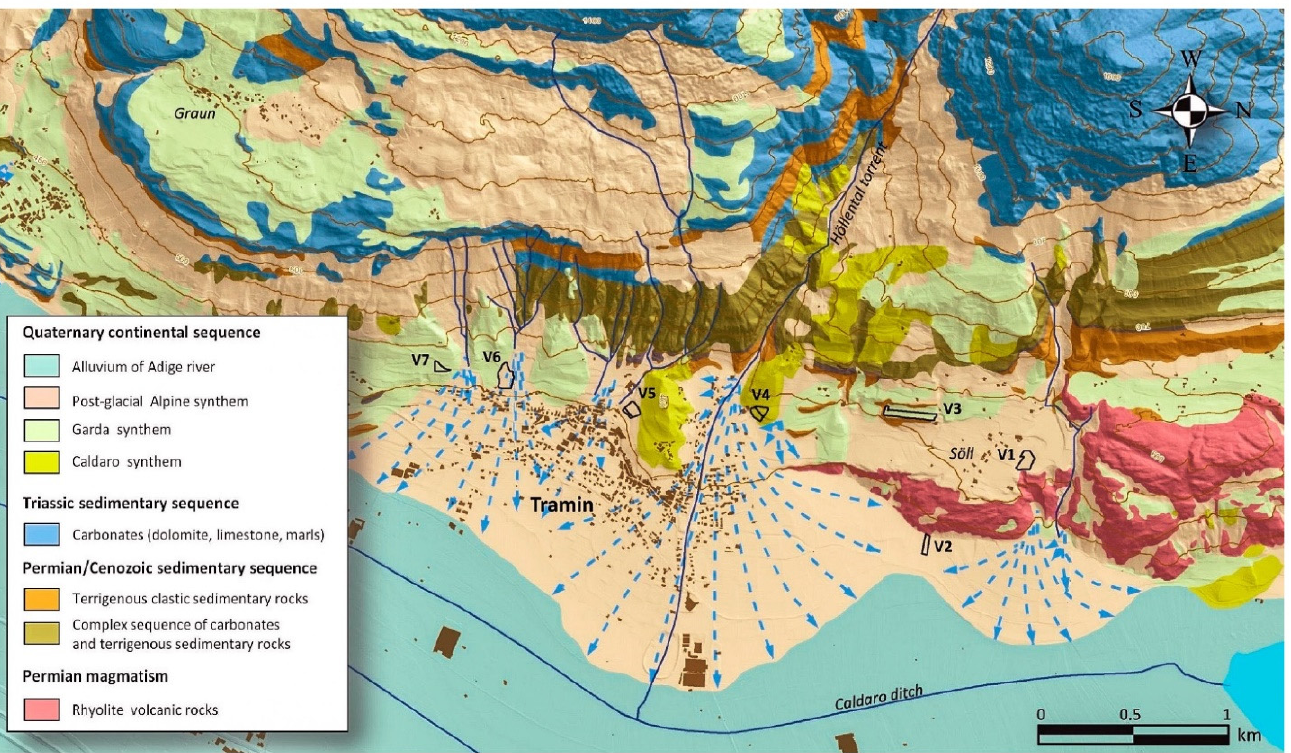
Figure 3. Geological information of the Tramin area. V1–V7 indicate the studied vineyards. All vines are located in sedimentary structural units (Synthems). These units are so heterogeneous and complex that they can appear on the geological map, as they were built in many lithostratigraphic events and sedimentary cycles.